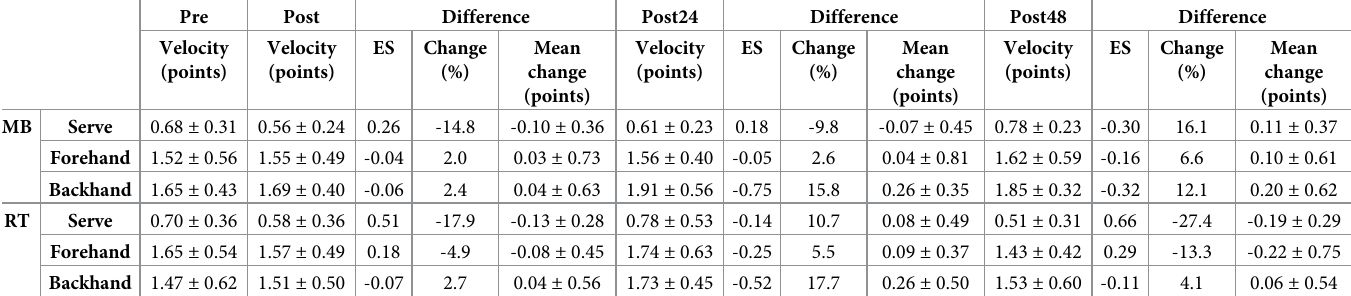
Table 4. Acute (Post) and delayed (Post24 and Post48) effects of medicine ball throws training (MB) and resistance training (RT) on accuracy and corresponding percentage changes from baseline. Pre Post Difference Post24 Difference Post48 Difference Velocity